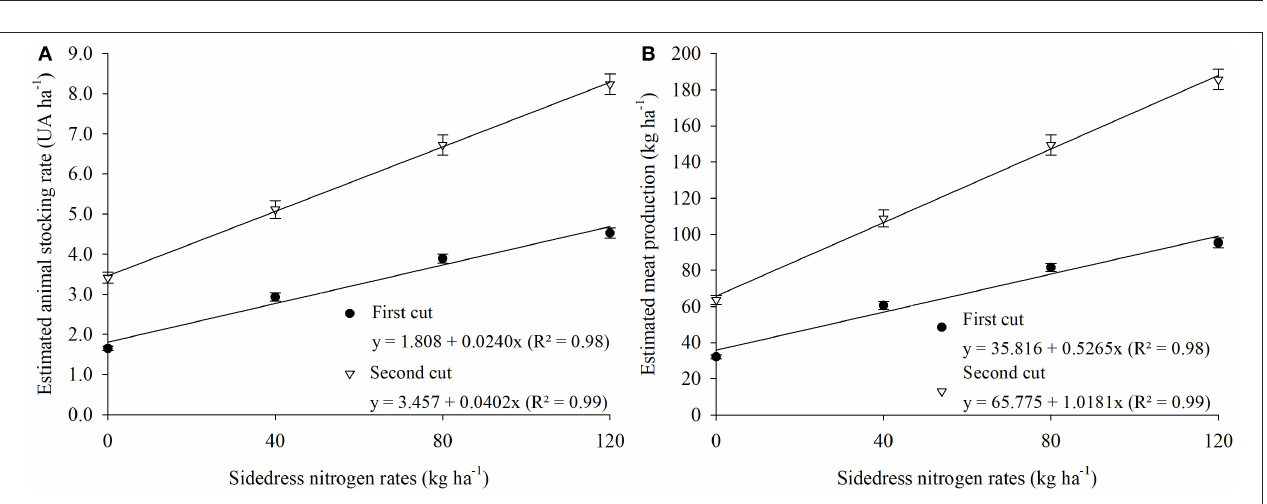
FIGURE 4 | Crop system × sidedress nitrogen rates interaction effect on forage dry matter production in the first cut (A) , forage dry matter production in second cut (B) , and crude protein concentration at second cut as affected by sidedress nitrogen rate (C) . Each data point is the mean of 24 replicates (two cropping systems, four blocks, and three growing seasons) and associated error bar is ± one SE. * P ≤ 0.05.